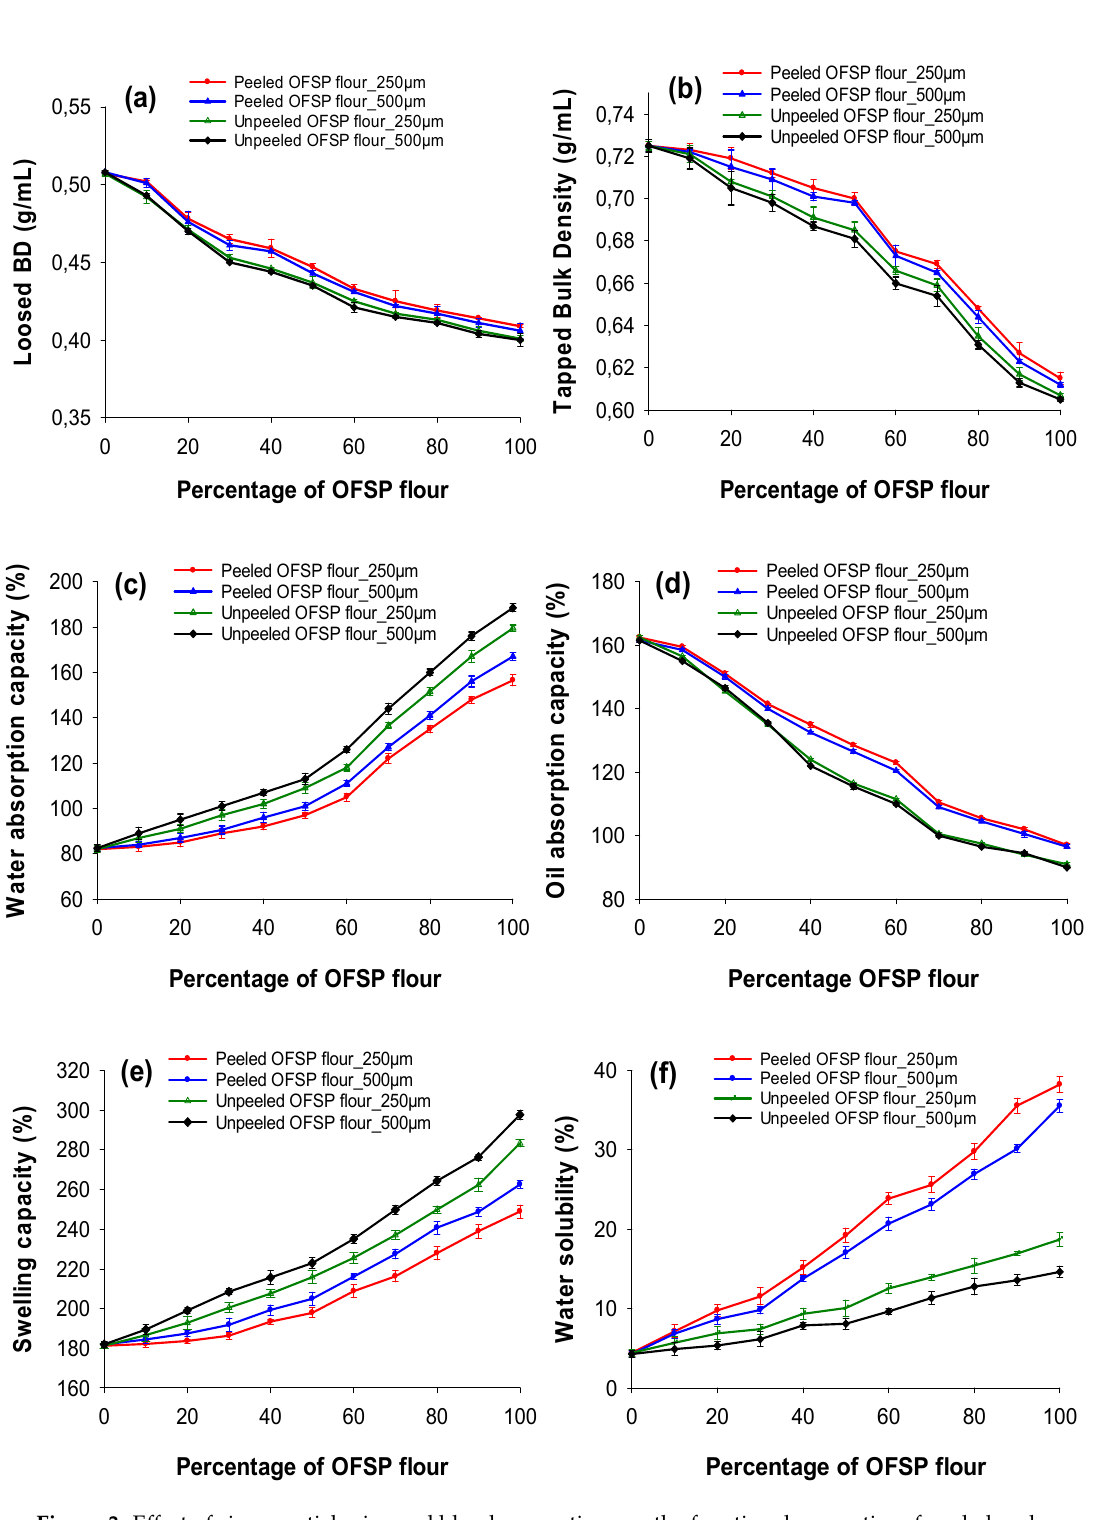
Figure 3. Effect of sieve particle size and blend proportions on the functional properties of peeled and unpeeled OFSP composite flours. ( a ) Loose bulk density (BD); ( b ) Tapped BD; ( c ) Water absorption capacity; ( d ) Oil absorption capacity; ( e ) Swelling capacity; ( f ) Water solubility. Values are expressed as mean ± standard deviation ( n = 2). Significant difference between means was determined at p < 0.05.